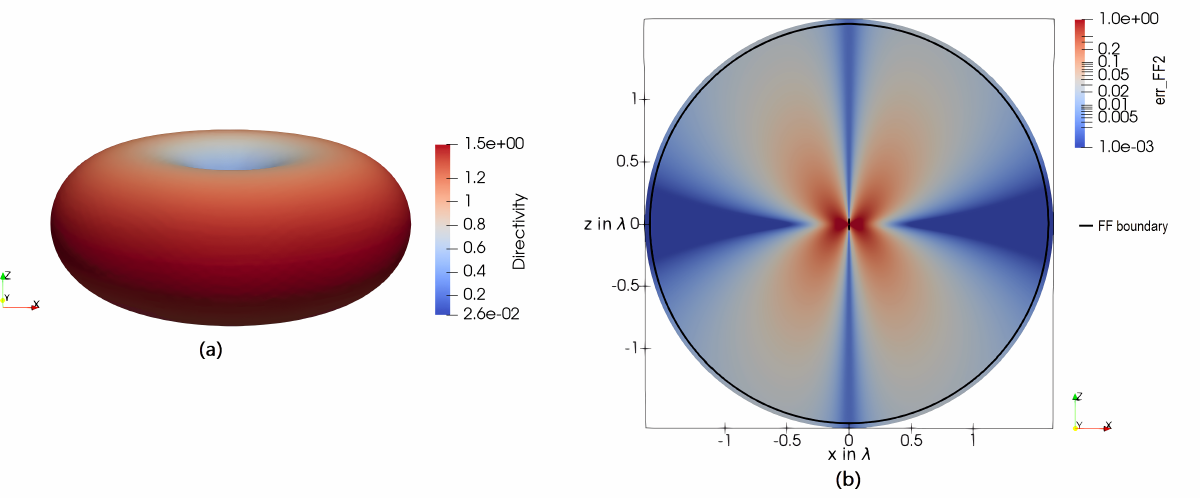
Figure 7. ( a ) A 3D plot of the directivity D ( θ , φ ) of a 0.1 λ dipole. ( b ) The error-estimator 6, describing a qualitative measure of the FF quality, applied on a 0.1 λ dipole in the E-plane. The FF boundary r far for the given antenna dimension l = 0.1 λ given in 4 is displayed as a black